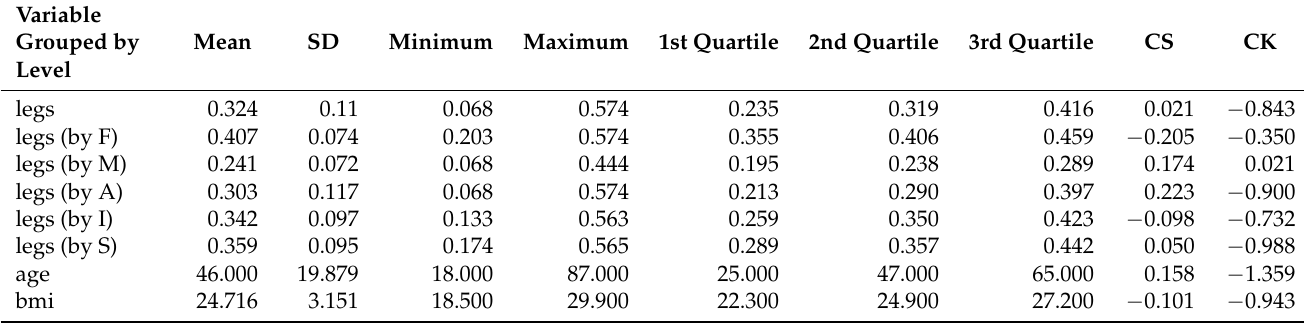
Table 1. Univariate descriptive statistics of data related to the fat percentage at the legs.